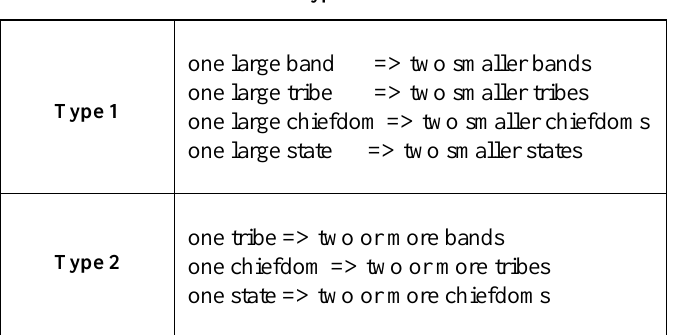
Table II. Two types of social